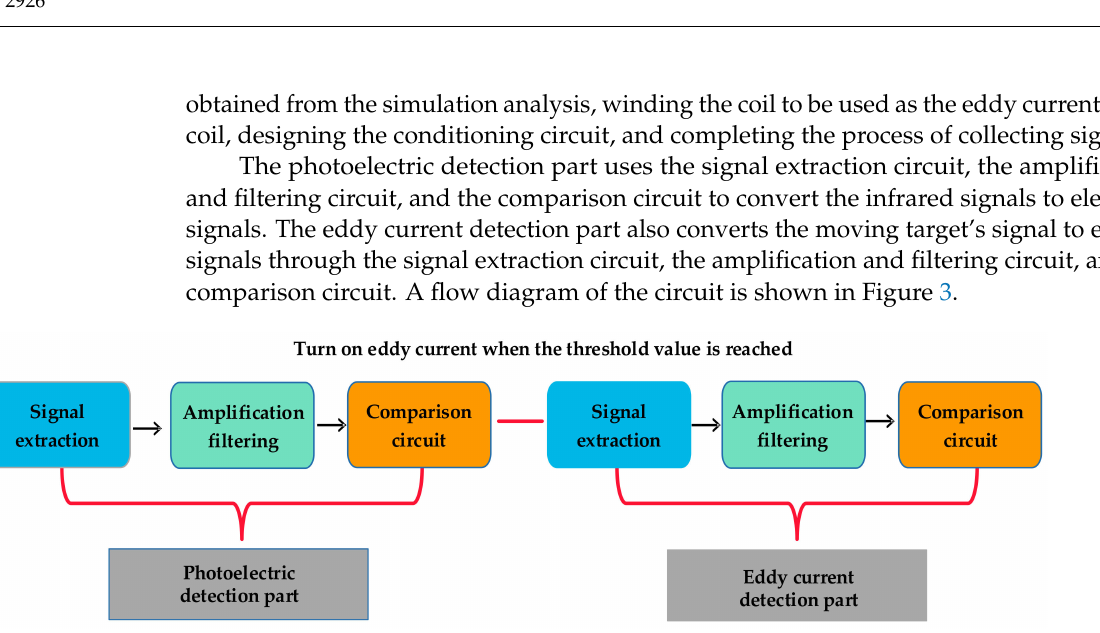
Figure 3. Circuit flow chart.